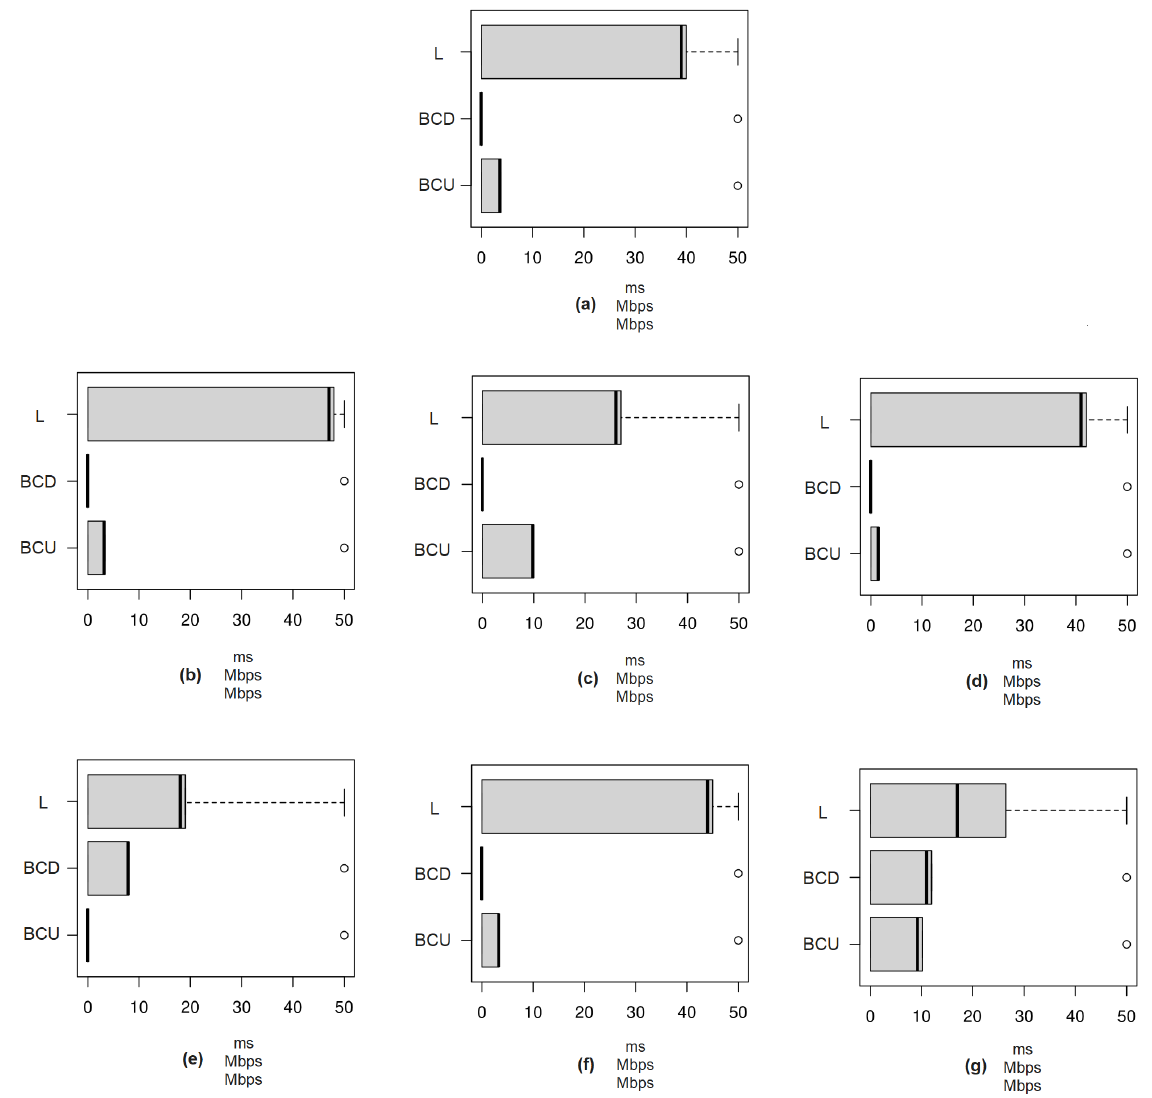
Figure 20. Boxplot of tests in the second phase of the 5G private network for PoC-2-1. ( a ) Test 1: